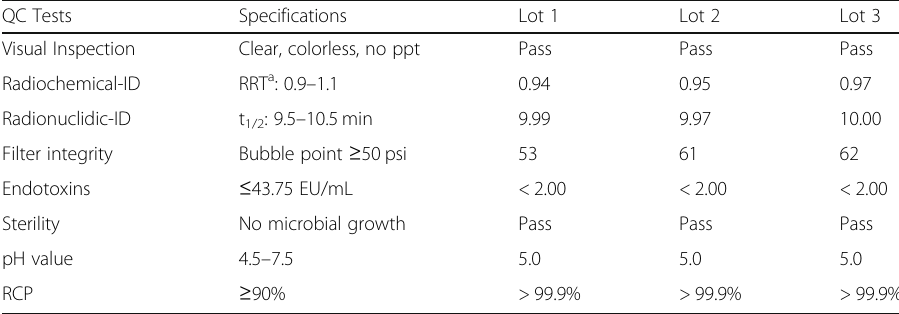
Table 4 QC Data for [ 13 N]NH 3 validation runs. All doses met or exceeded release criteria for clinical application at the University of